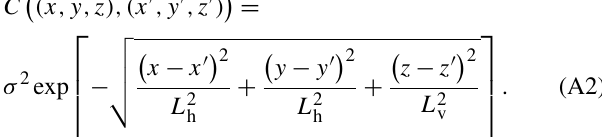
Table B1. Average measurement error for 11 to 12km